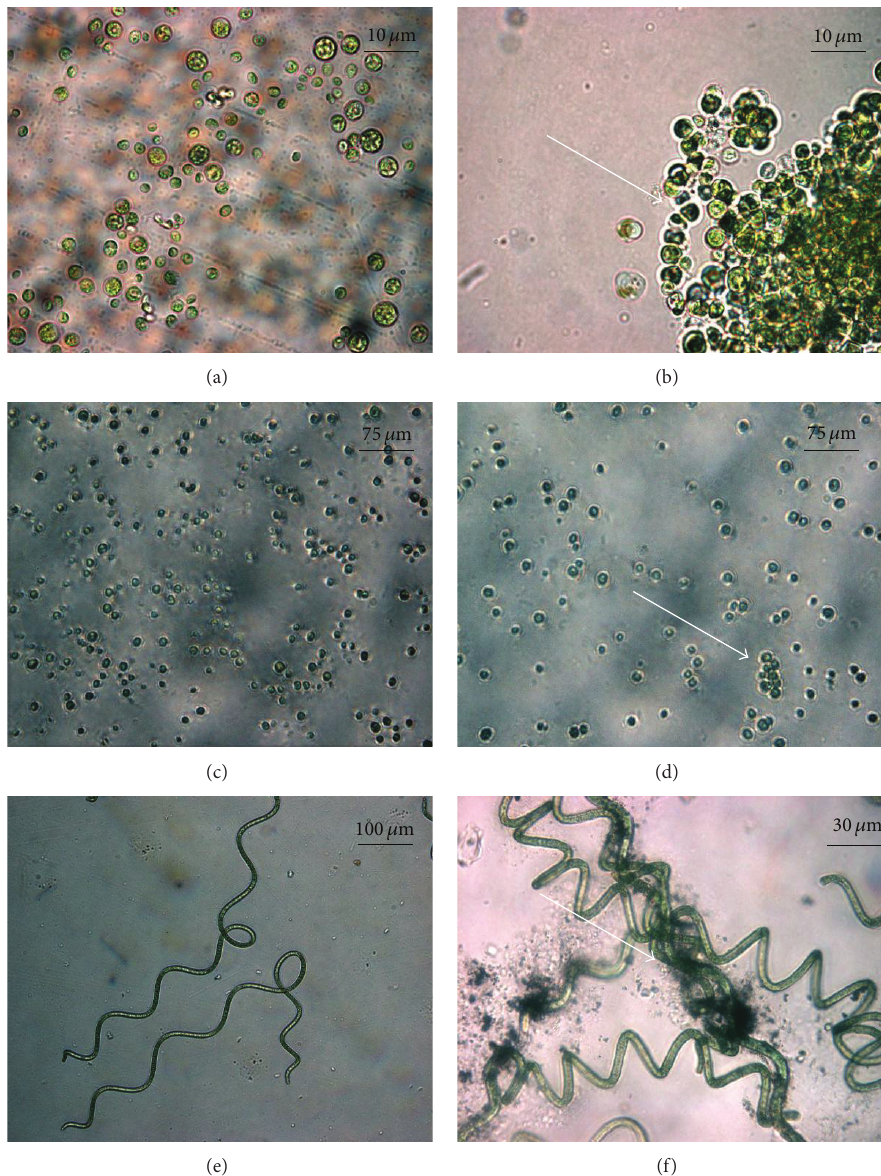
Figure 4: The effect of TiO 2 NPs on cell morphology showed by phase contrast microscopic images. (a) and (b) show images of Chlorella vulgaris (100x); (c) and (d) show images of Haematococcus pluvialis (40x); (e) and (f) show images of Arthrospira platensis (40x and 100x, resp.). Left columns (a, c, and e) show the images for control tests of each microorganism while right columns (b, d, and f) show images of TiO 2 NPs treated microorganisms. Arrow marks indicate the cellular aggregations and cellular wall